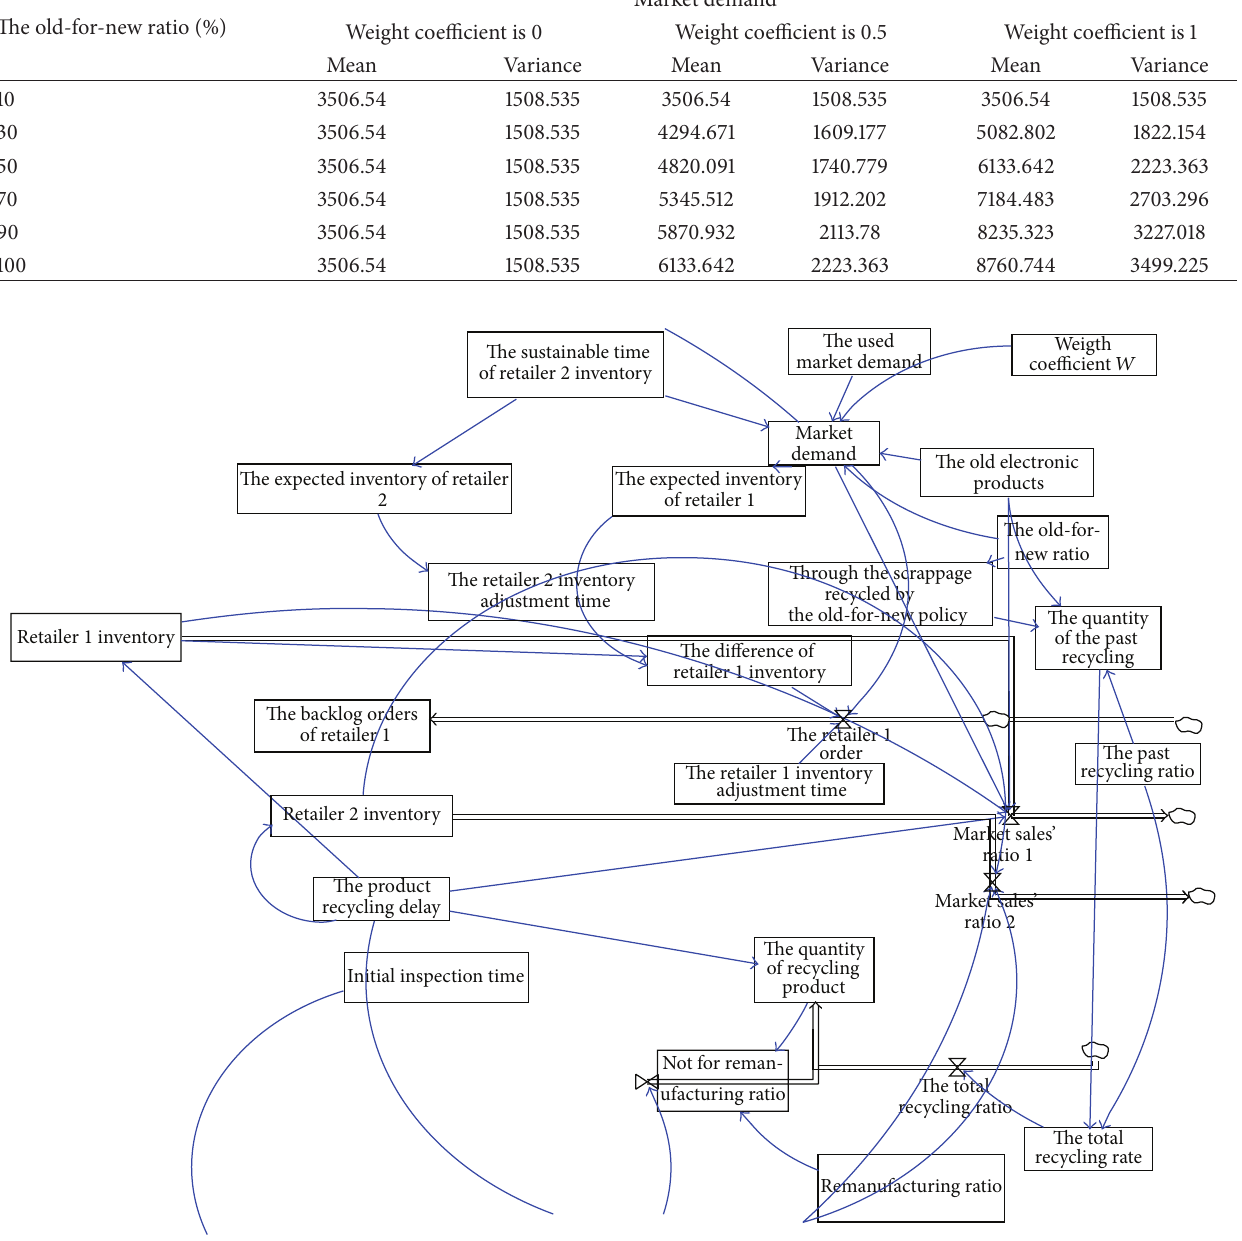
Figure 3: The old-for-new policy affects the system’s